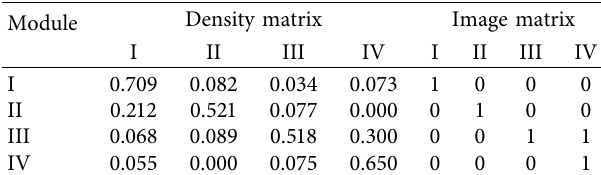
Table 6: Density and image